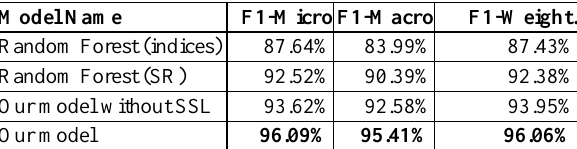
Table 3. Performance Comparison under spatial variance